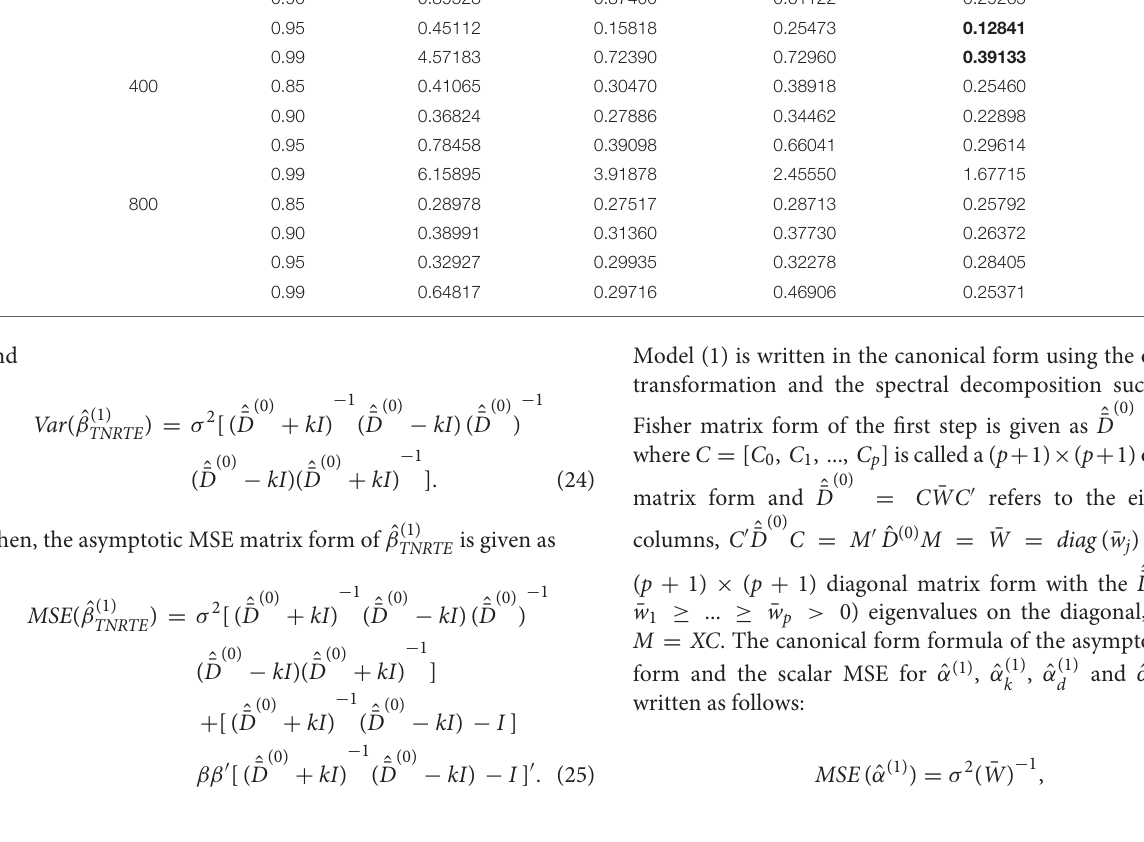
TABLE 2 | Simulation results in case of p